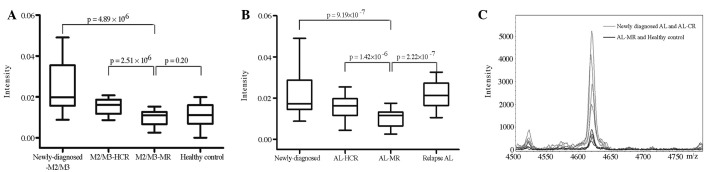
Intensity levels of m/z 4625 peptide in AL and healthy control groups. (A) Boxplot display of m/z 4625 distributions for newly-diagnosed M2/M3, M2/M3-CR, M2/M3-MR and healthy controls. (B) The intensity distribution of m/z 4625 in newly-diagnosed AL, AL-HCR, AL-MR and AL-relapse. The box is bound above and below by the 75th and 25th percentiles and the median is the line within the box. (C) Spectra of the m/z 4625 peptide randomly obtained from newly-diagnosed AL, AL-CR and AL-MR patients and healthy controls. AL, acute leukemia; CR, complete remission; MR, molecular remission; HCR, hematological complete remission.